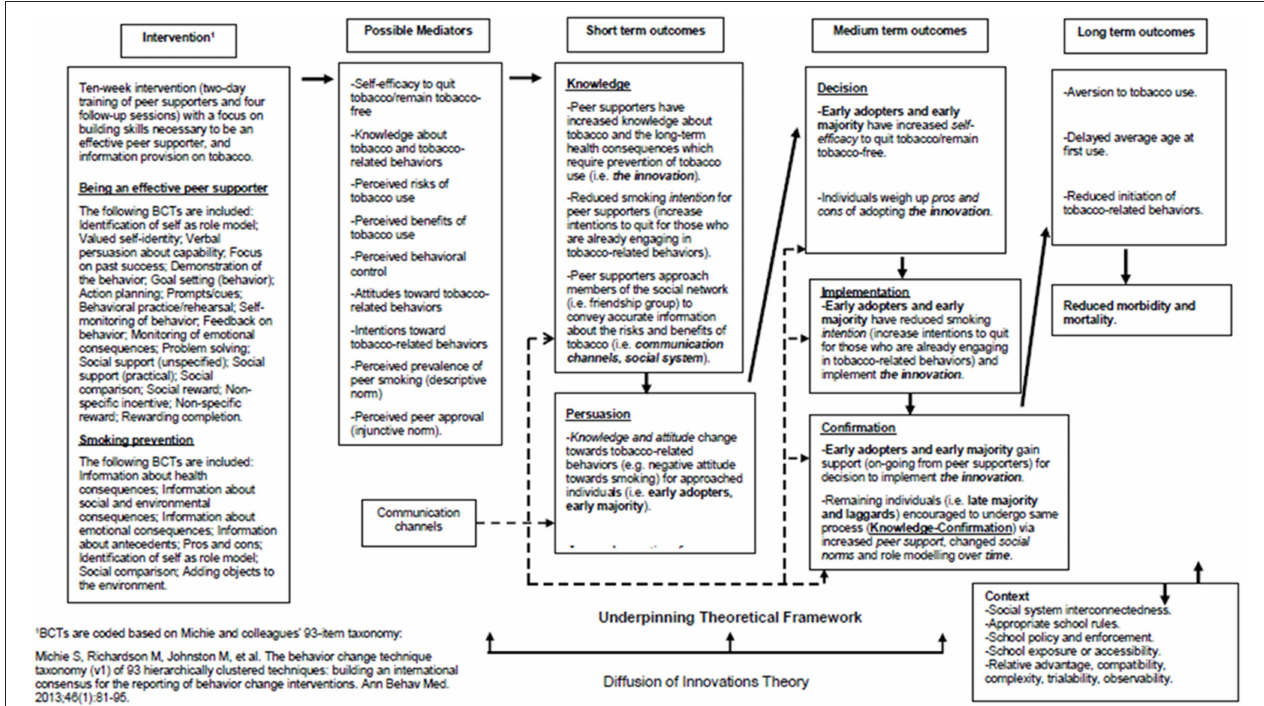
FIGURE 1 | Proposed logic model for the ASSIST intervention.